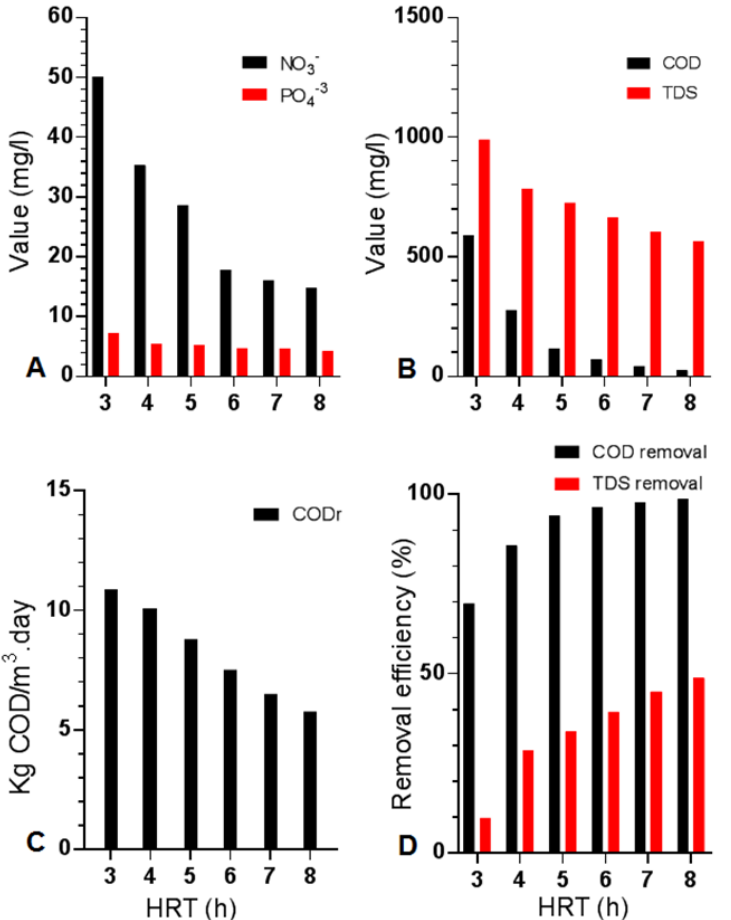
Figure 3. MBBR system monitoring for different hydraulic retention time (HRT) periods and different biochemical